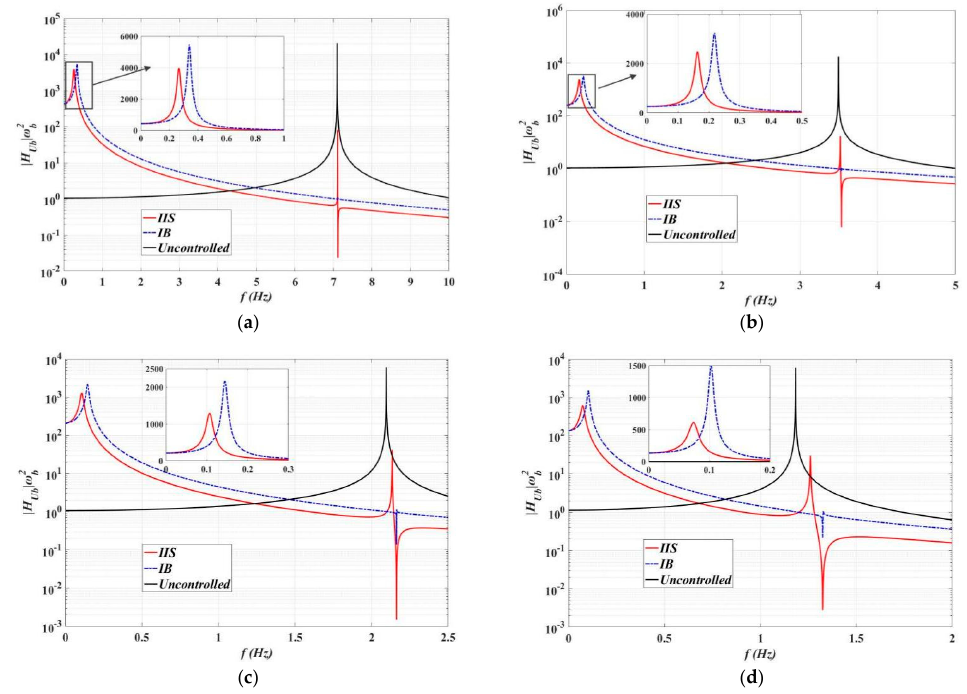
Figure 14. Displacement amplification factor of bushings: ( a ) HB–1 ; ( b ) HB–2 ; ( c ) LB–1 ; ( d ) LB–2 .